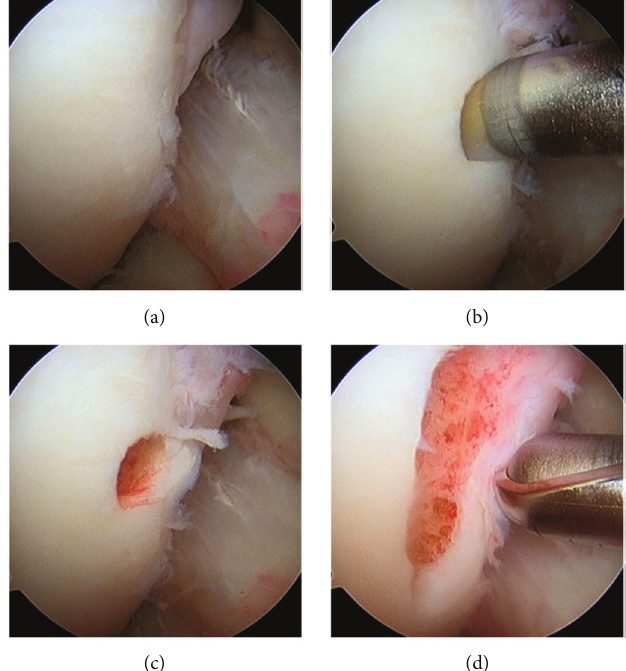
Figure 6: Cartilage biopsy. (a) Lateral intercondylar notch. (b) Needle biopsy. (c) Initial biopsy site. (d) Completed